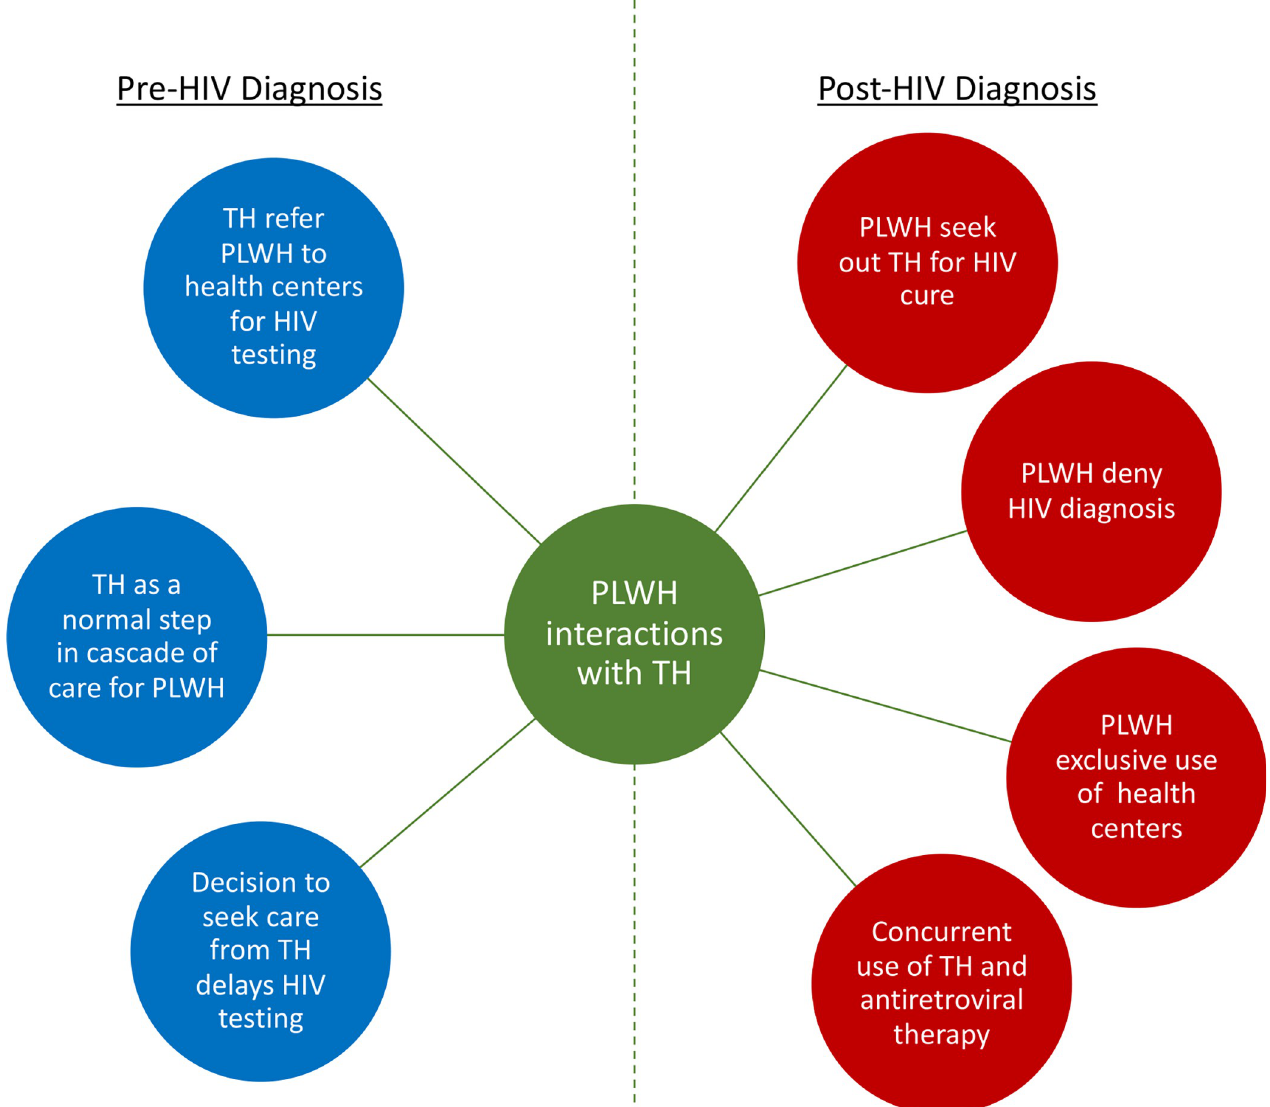
Fig 1. Schematic representation of traditional healers’ (TH) engagement with people living with HIV (PLWH) before and after HIV